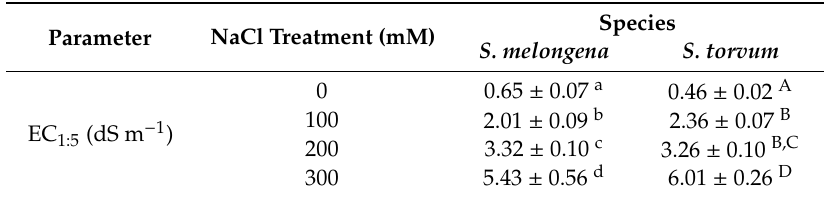
Table 1. Electrical conductivity (EC 1:5 ) of pot substrates after 25 days of salt treatment with the indicated NaCl concentrations. Numbers represent means ± SE ( n = 5).